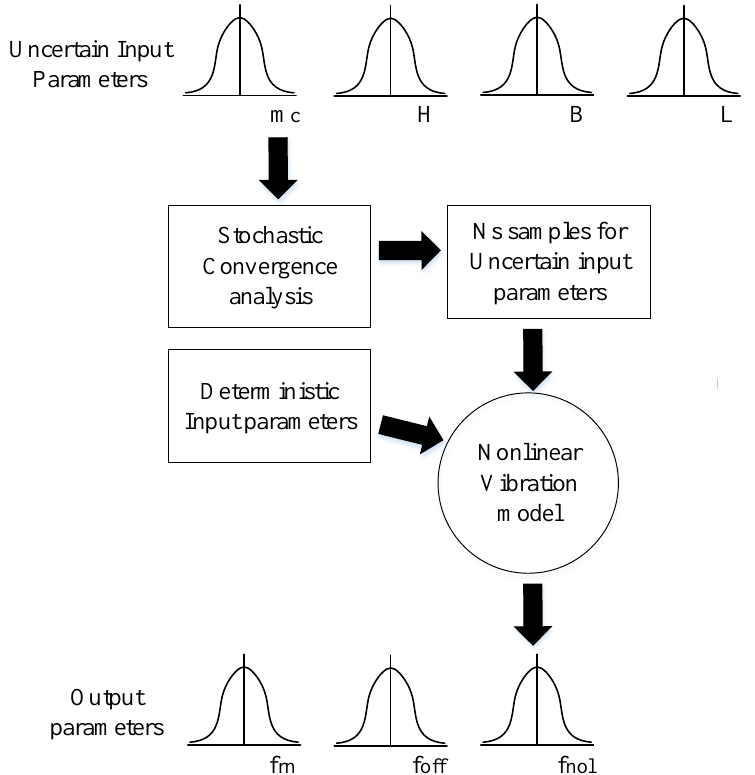
Figure 5. The sample-based stochastic